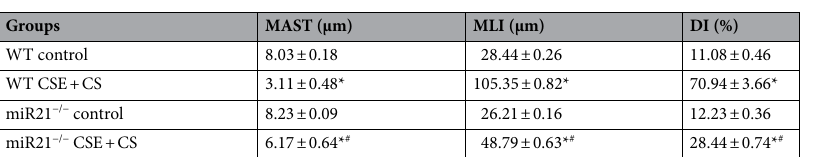
Table 3. Morphological changes in the mouse lung following CS-exposure. Morphometric measurements of MAST (μm), MLI (μm) and DI (%) were performed in each group. *P < 0.05 versus WT control group; # P < 0.05 versusWT CSE + CS group (n =